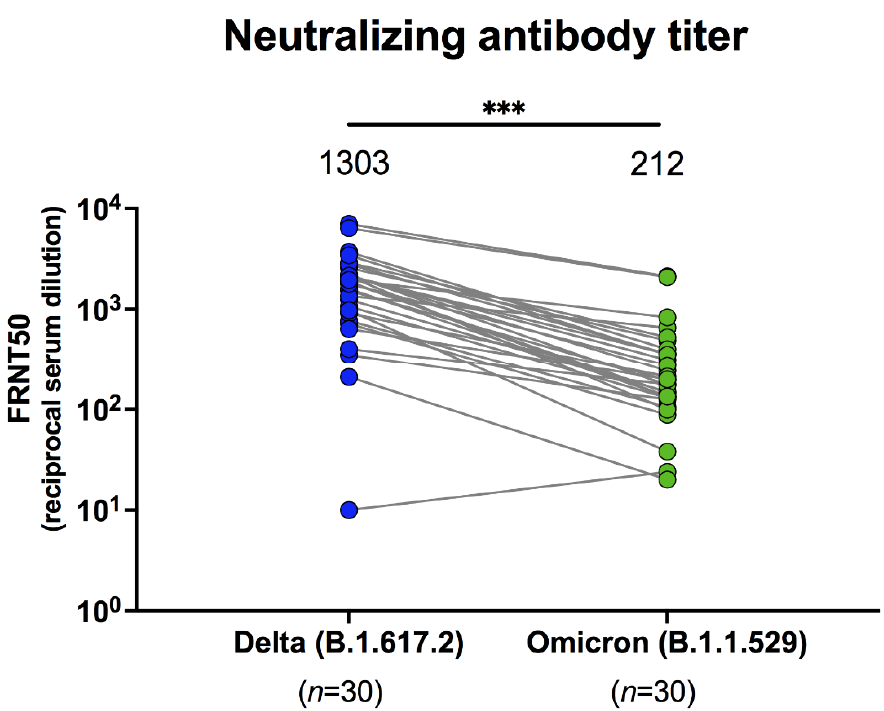
Figure 3. Live SARS-CoV-2 serum dilution titres were determined against B.1.617.2-delta and B.1.1.529-omicron in serum samples from individuals with breakthrough infection determined using focus reduction neutralization test 50 values (FRNT50). Number indicates the geometric mean titres with 95% CIs. Statistics were calculated using Wilcoxon matched pair signed rank test. *** p < 0.001.